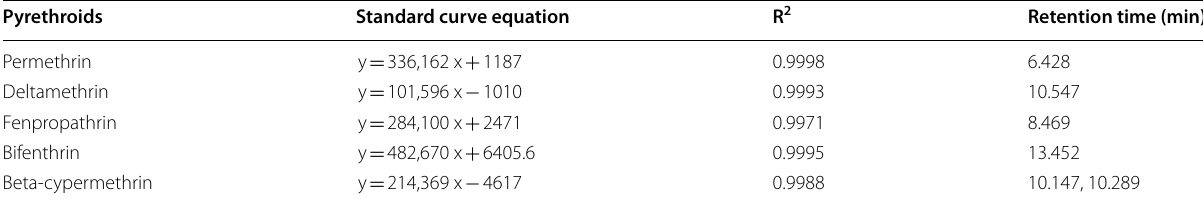
Table 2 Standard curve equation of pyrethroids